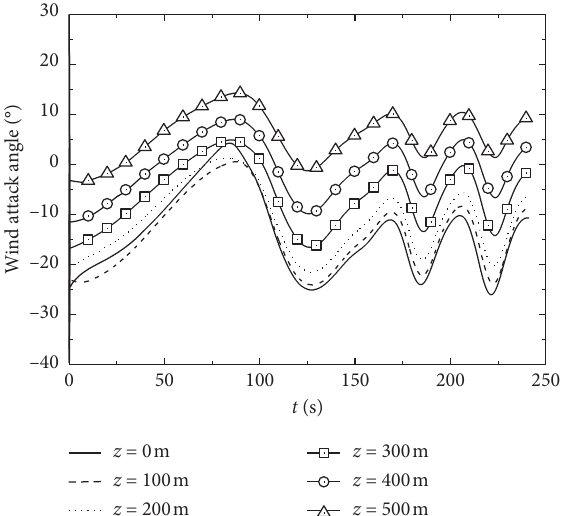
Figure 12: Time-history curves of wind attack angle in the gorge